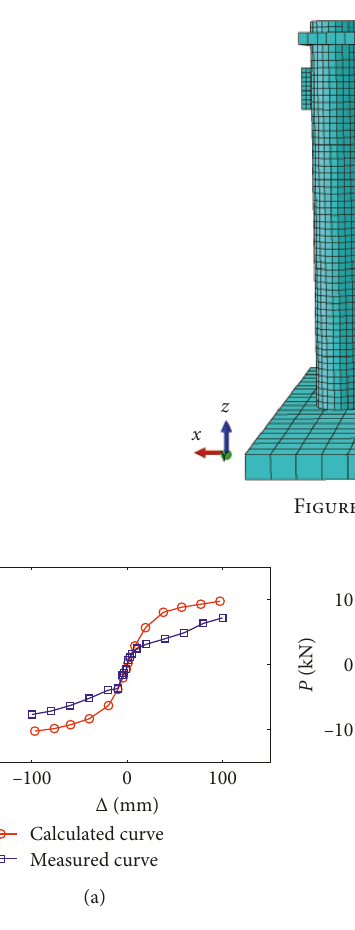
Figure 15: Comparison of experimentally determined and numerically simulated skeleton curves for unilateral column foot damage (ZJJ). (a) ZJJ40. (b) ZJJ80. (c) ZJJ105.